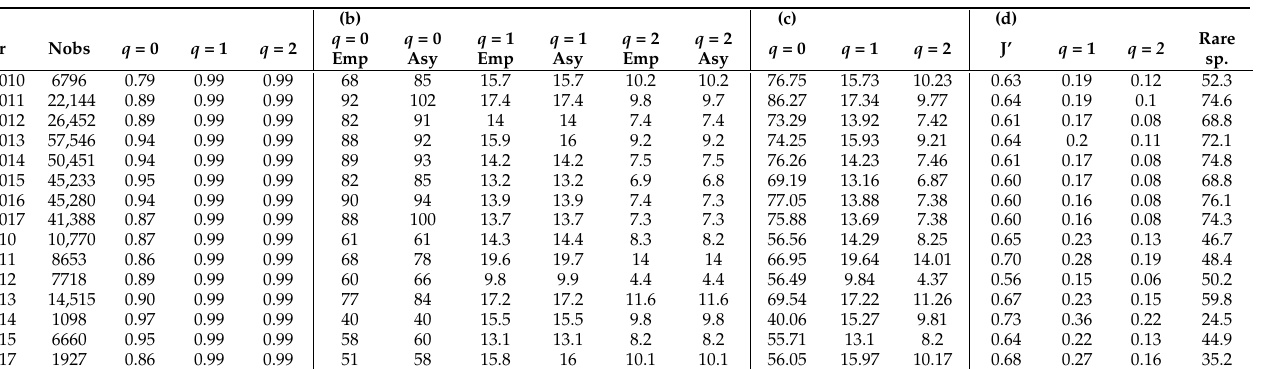
Table 1. Four-Step sample completeness evaluation, numerical values of the indicators q = 0, 1, and 2 for abundance-based reef fish data from Marietas Island (MI) and Isabel Island (II) in 2010–2017. (a) Annual sample completeness profile for MI and II; (b) Empirical (Emp) and asymptotical (Asy) of q = 0, 1, 2; (c) non-asymptotic coverage-based rarefaction and extrapolation to the maximum standardized SC of 0.99; and (d) Pielou’s evenness (J’) among species abundance to the maximum standardized SC. Nobs: Number of